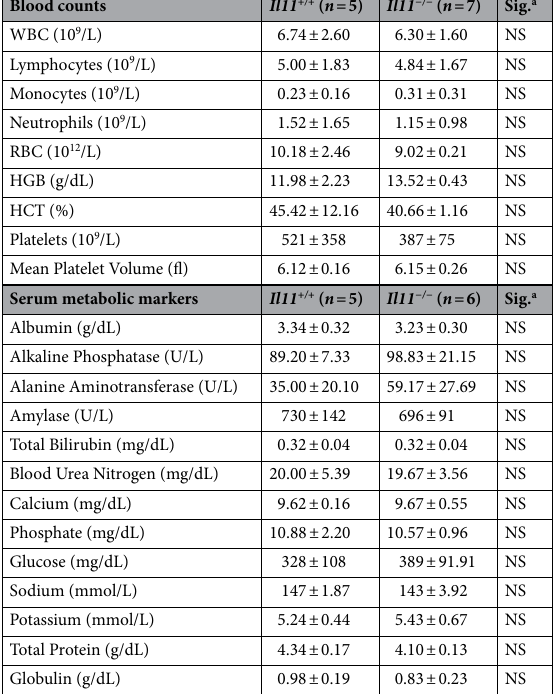
Table 1. Hematology and serum metabolic profiles of Il11 knockout mice. Data shown as mean ± SD. WBC white blood cells, RBC red blood cells, HGB hemoglobin count, HCT hematocrit, NS non-significant. a Significance was determined using Bonferroni post-hoc